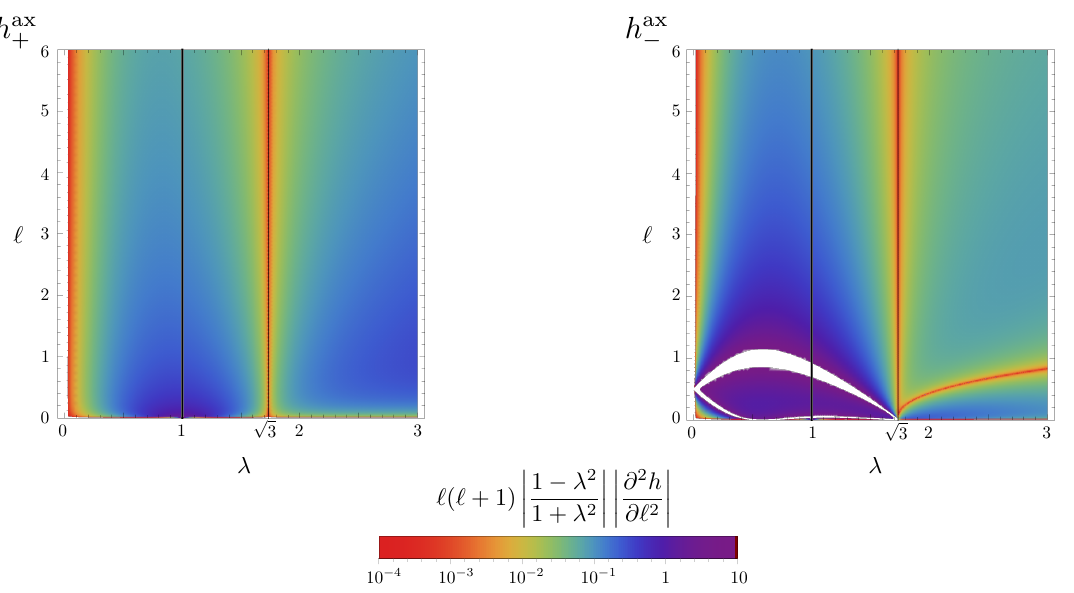
for the two axial modes perturbing our ± in eq. (3.4) via ±